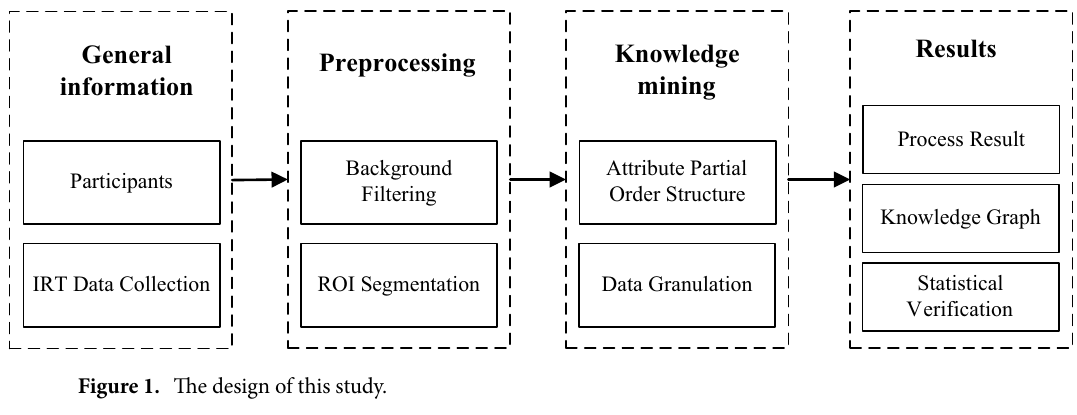
Figure 1. The design of this